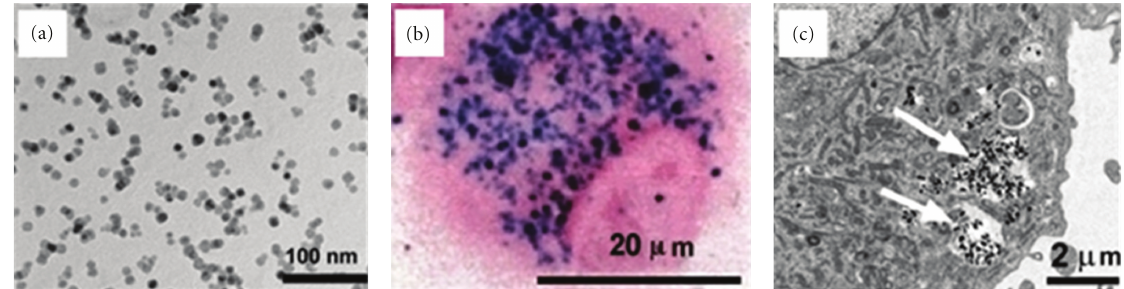
Figure 3: Nanoparticles. Labeling of cells with nanoparticles for magnetic-driven tissue engineering [3]: (a) Transmission electron micrograph of a typical population of metallic nanoparticles; (b) Light micrograph of human mesenchymal cells derived from bone marrow, which are capable of vascular lineage di ff erentiation. The cells have been labeled with superparamagnetic iron oxide nanoparticles. Staining with Prussian Blue indicates the presence of nanoparticles inside of cells. (c) Transmission electron micrograph of human endothelial cells that were labeled with nanoparticles. White arrows indicate clusters of nanoparticles that had been endocytosed inside the